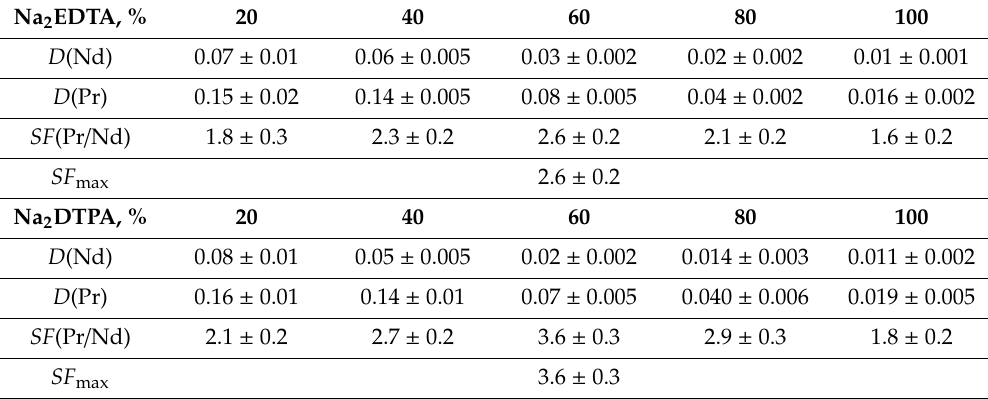
Table 2. Distribution ratios and separation factors for the system “0.5 mol∙L −1 Aliquat 336 in